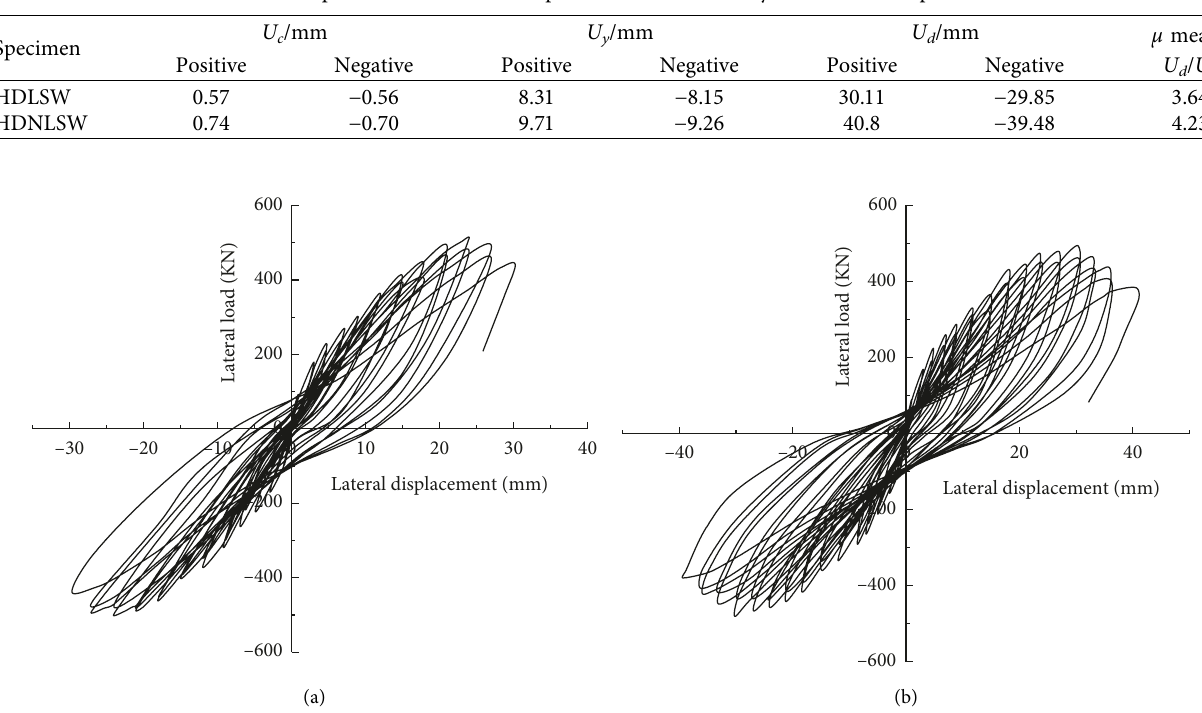
Table 4: Experimental results of displacements and ductility coefficients of specimens.